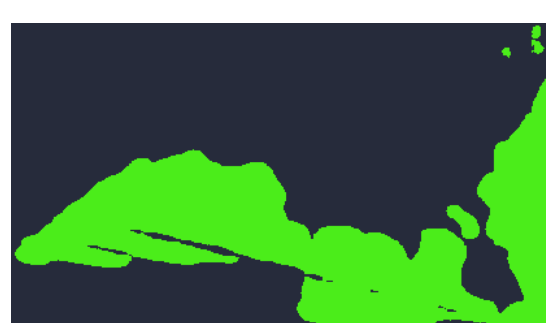
Figure 8. Candidate ocean regions, green : ocean, black:Land As it is shown in Figure 9, applying an area threshold removes the non-ocean regions, and then the points which correspond are selected as the ocean points.